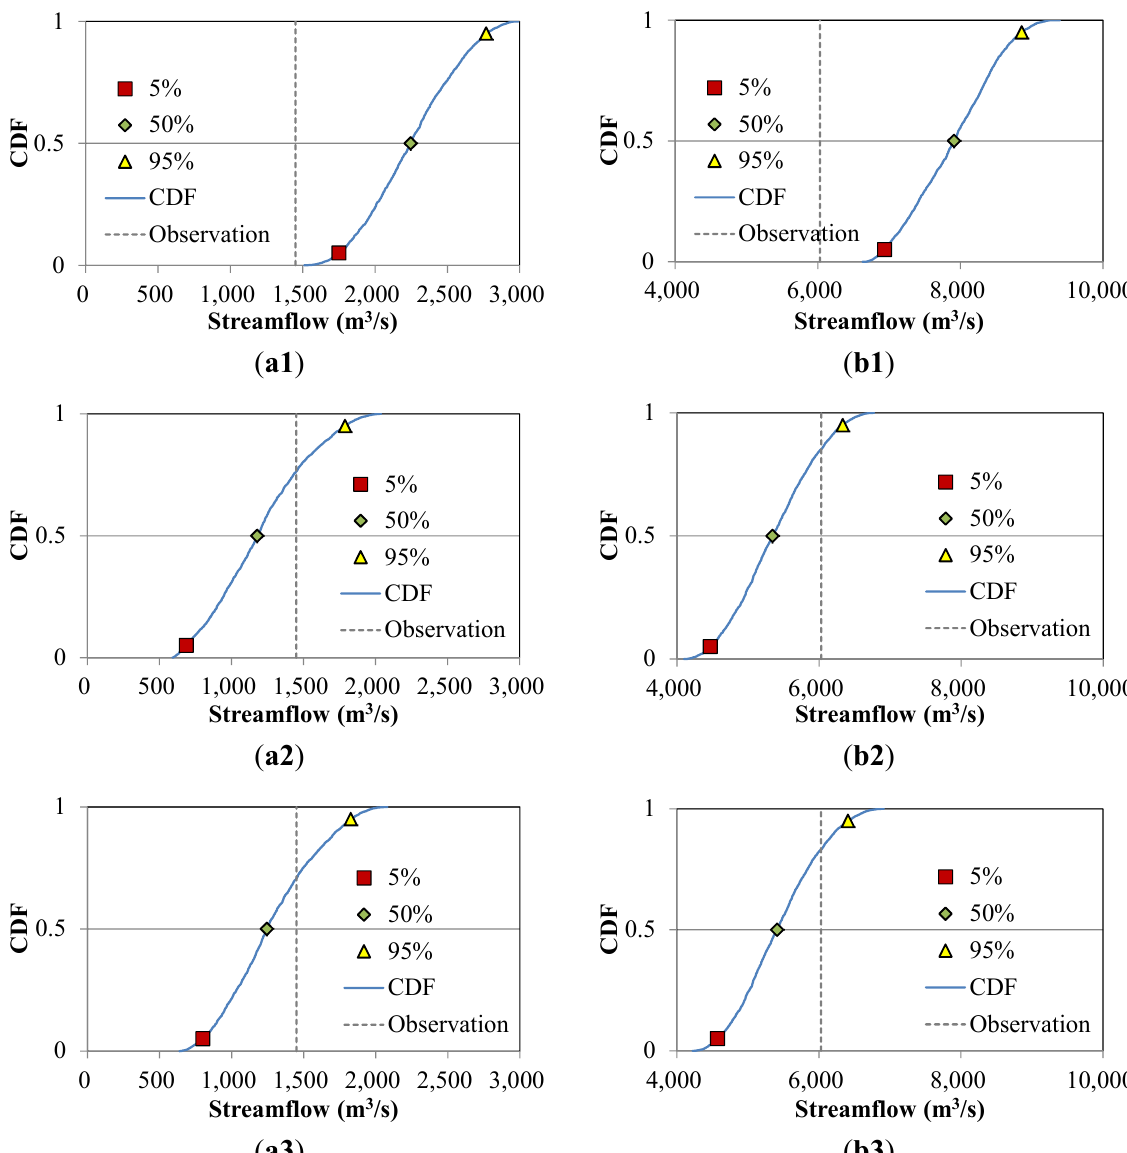
Figure 7. Cumulative density function (CDF) obtained by taking top 30% of likelihood measure and the 5%, 50%, and 95% boundaries of the approximated flood